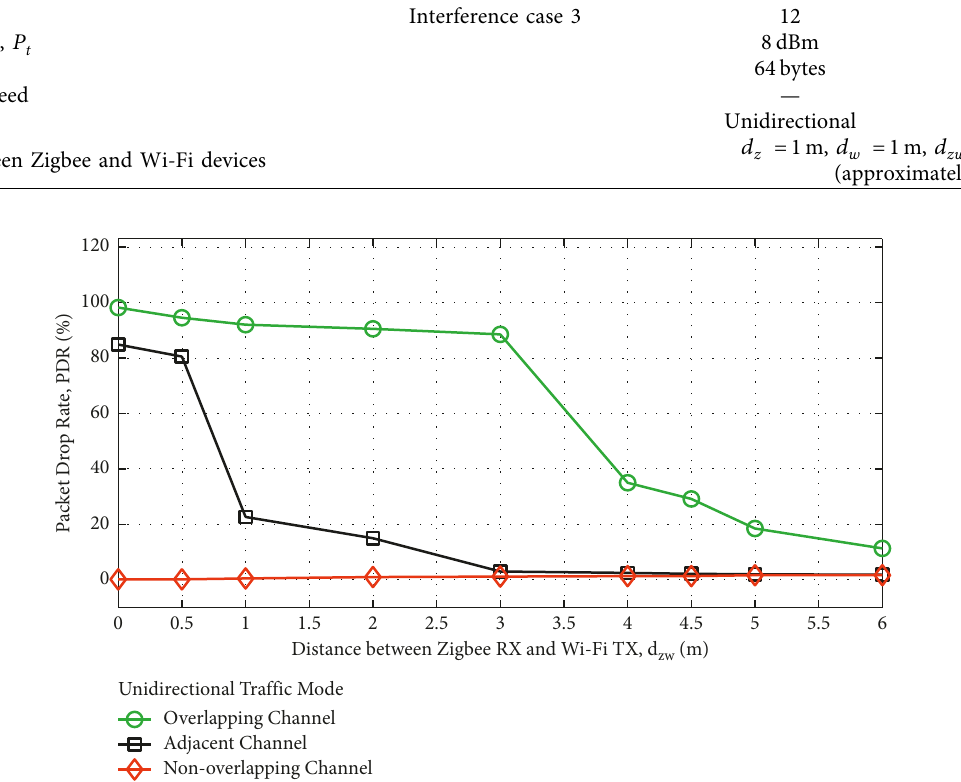
Figure 8: PDR versus d zw for three interference